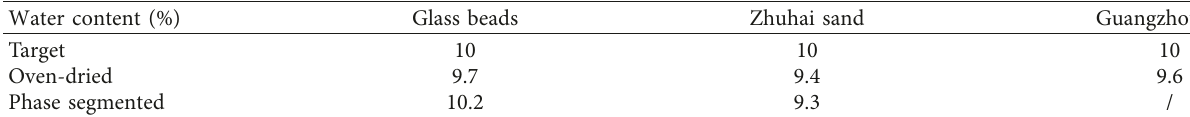
Table 3: Water content determined by different